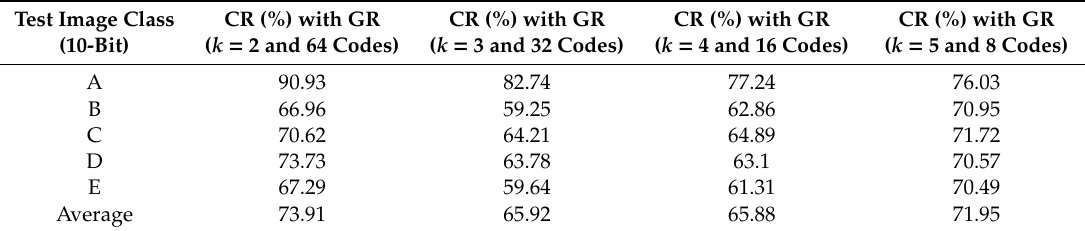
Table 9. CR comparison with GR with di ff erent codewords for 10-bit images.